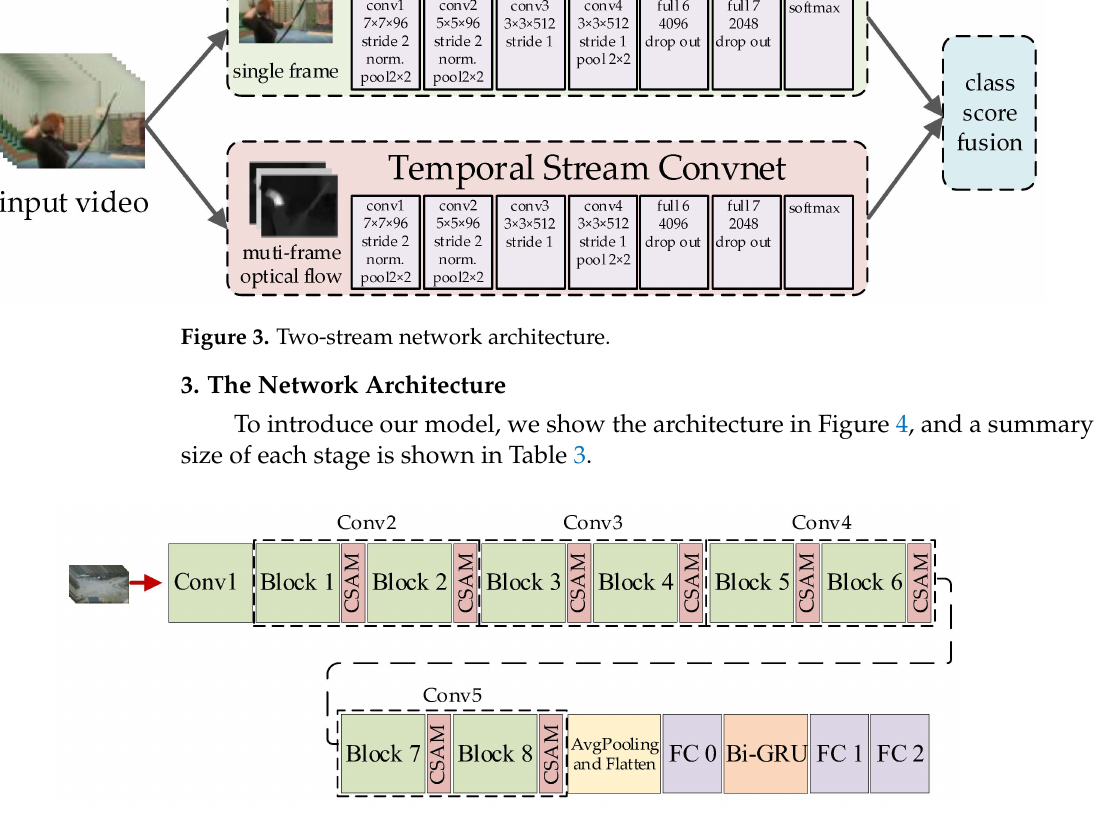
Figure 4. The architecture of our model. Table 3. The size of each stage in our